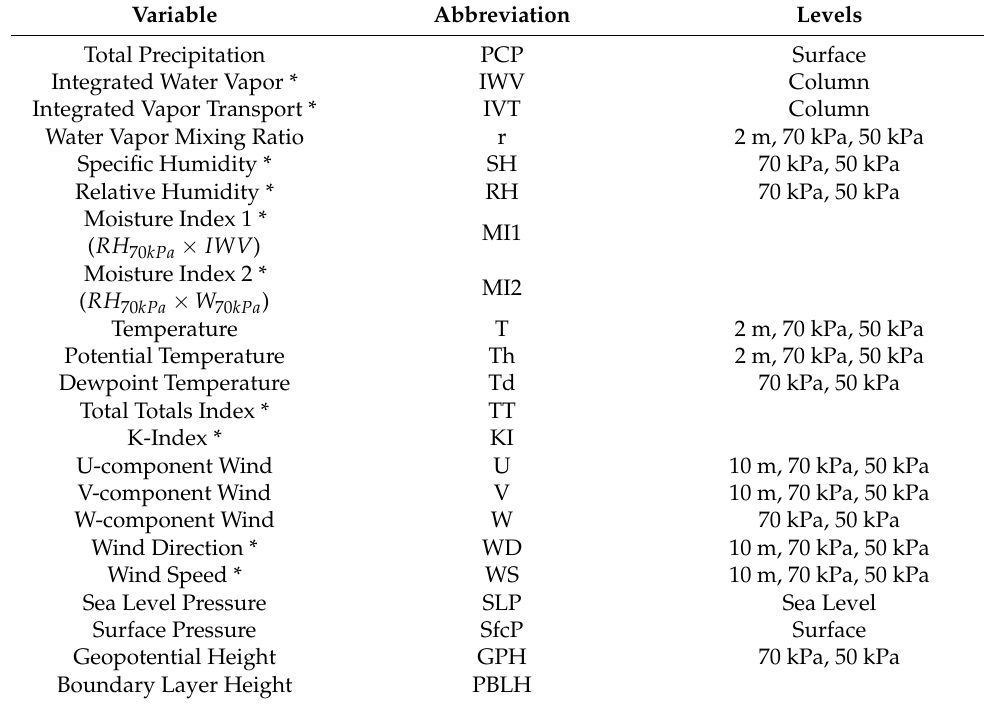
Table 1. Physical variables extracted from the WRF model output and considered as predictors.